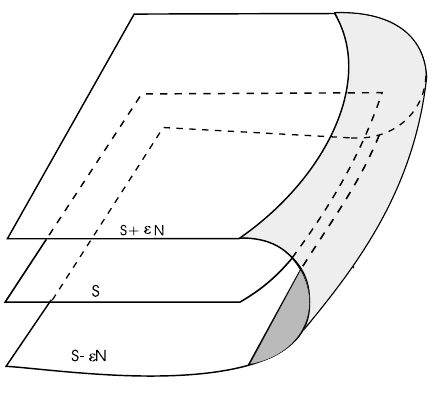
Fig. 1 – Thickening of the surface S